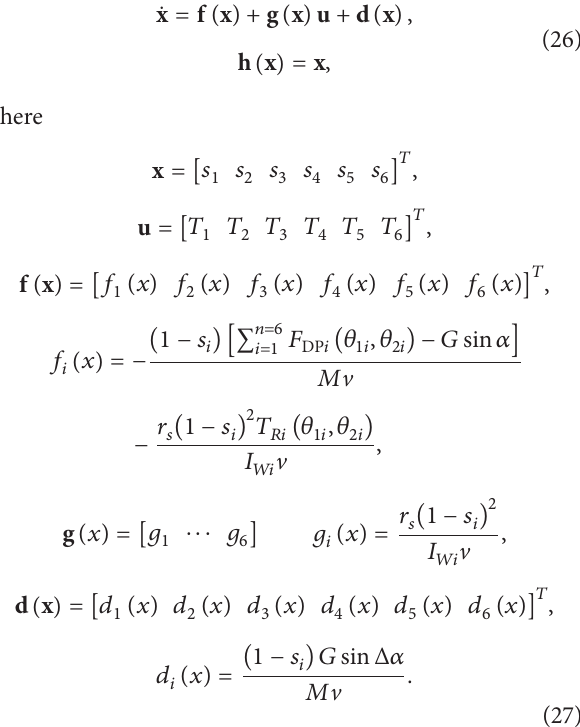
Figure 4: Flowchart of desired slip ratio based on optimal drive efficiency.